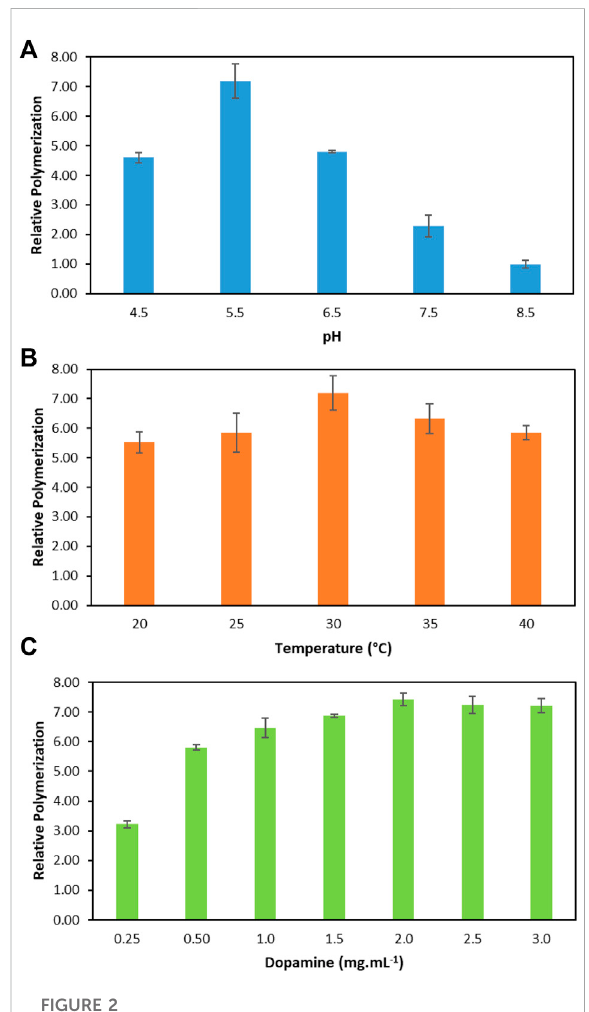
FIGURE 2 Relative dopamine polymerization in relation to the conventional reaction (without laccase, considered as 1). (A) At different pH values, 30 ° C and dopamine 2.00 mg ml − 1 . (B)